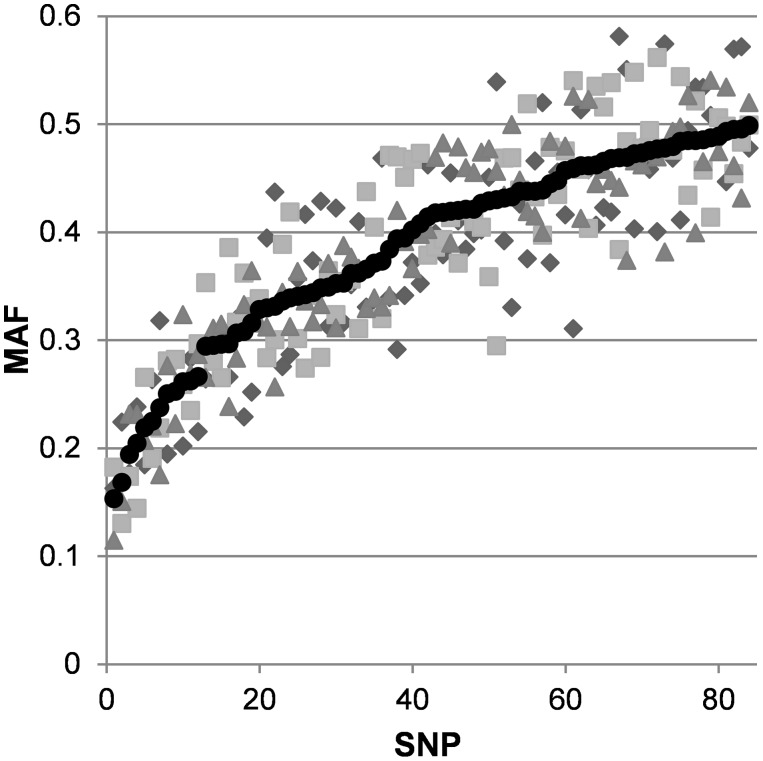
The minor allele frequency (MAF) of the 84 Parentage SNPs observed in three industry flocks.The average MAF is indicated by the black circles with Flock D (squares), Flock E (diamonds) and Flock F (triangles). The minor allele was determined from the average MAF.